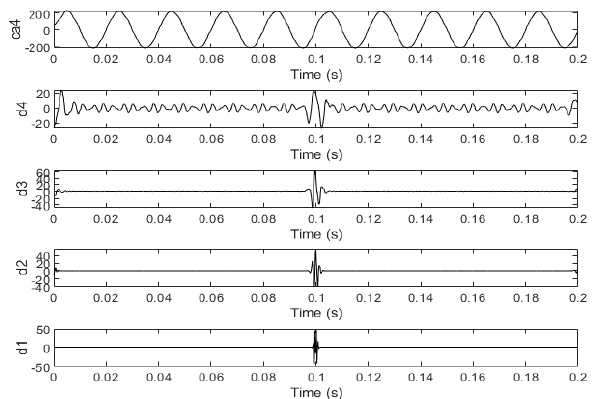
Figure 25. Impulsive transient.